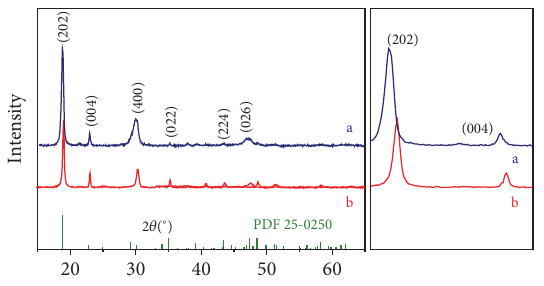
Figure 4: XRD images of the precursor (cobalt oxalate): (a) mechanical solid-state reaction; (b)